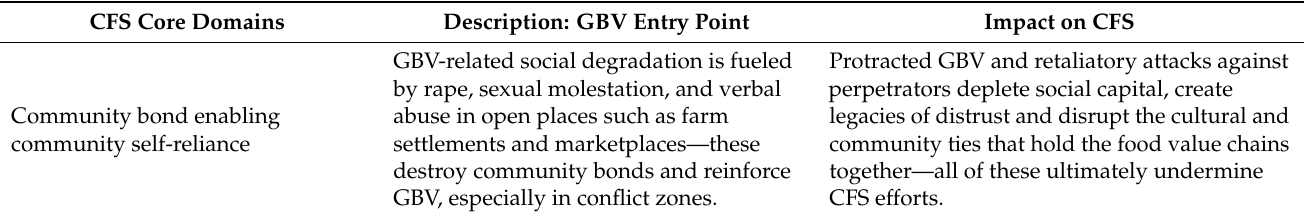
Community bond enabling community